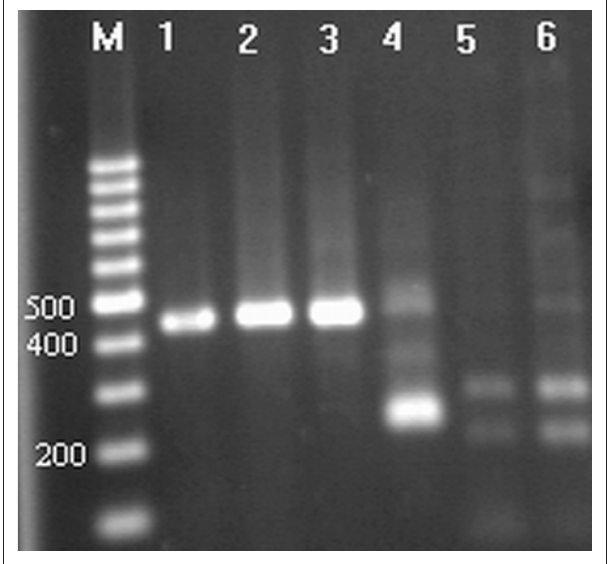
FIGURE 3: Comparison of restriction digests on Theileria species amplification